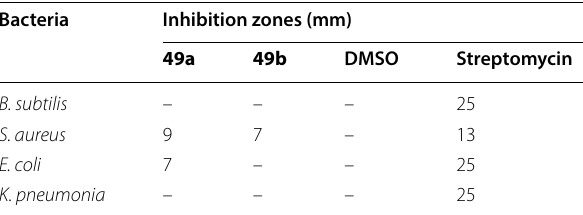
Minimum inhibitory concentrations was expressed as (µg/ml)